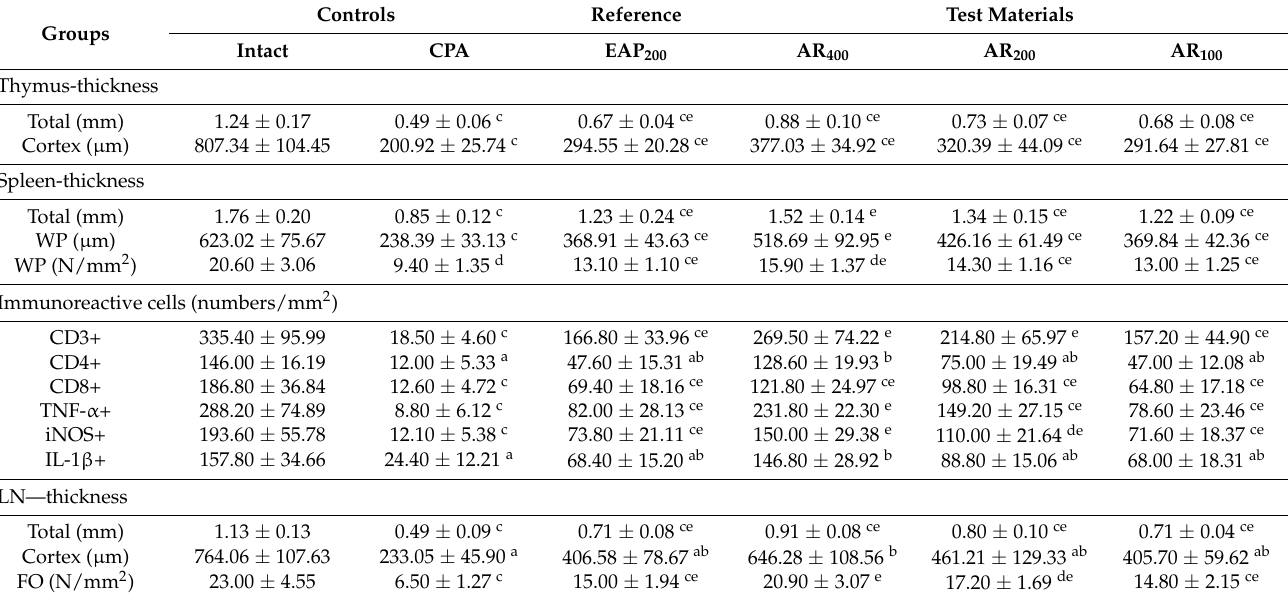
Table 8. Histomorphometric analysis in intact and CPA-induced immunosuppressed